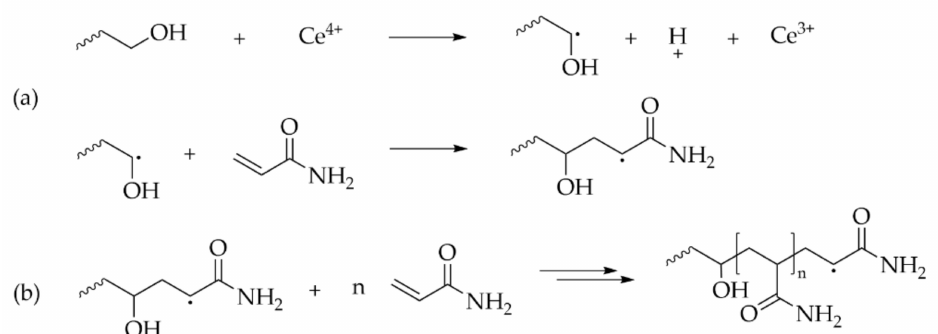
Figure 4. Mechanism of polymerization of acrylamide using Ce4+/alcohol redox system. ( a ) Radical generation and chain initiation; ( b ) propagation.